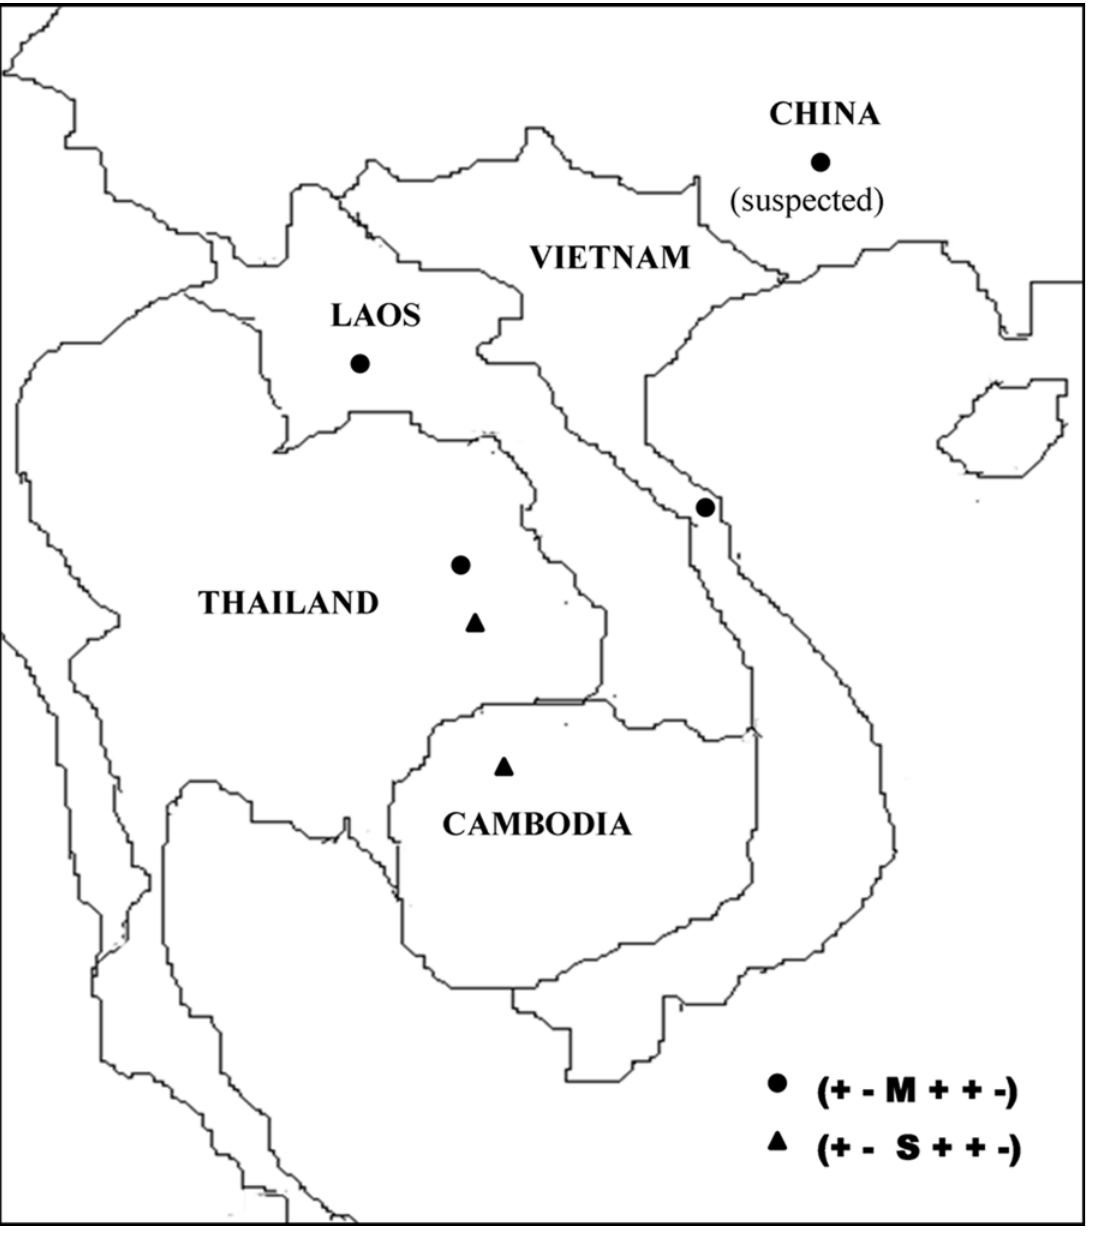
Fig 2. Map of Southeast Asia and China demonstrating distribution of the two major haplotypes associated with Hb CS alleles in the